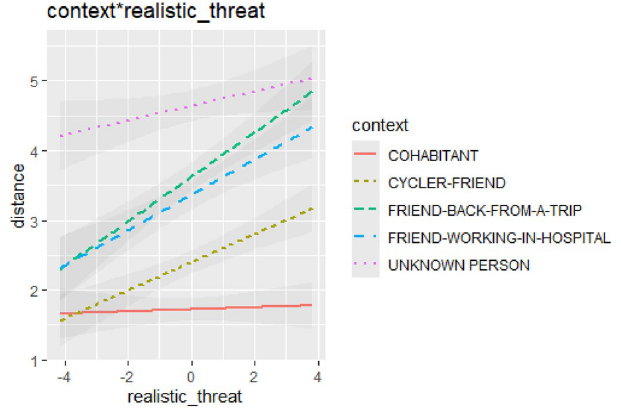
Figure 3. The graph shows the predicted values of the outcome variables. Shaded bands represent the confidence intervals (95%). The more participants showed high scores of Realistic Threat, the more they decided to keep a distance from the three categories of friends.